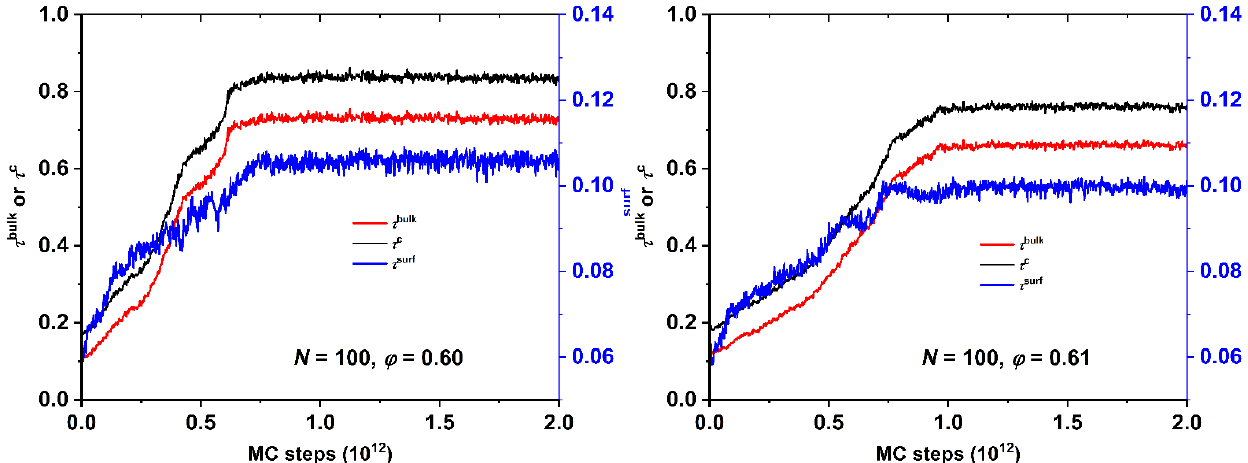
Figure 4. Double- y vs. x plots of bulk and total (left y-axis) and surface (right y-axis) versus the MC steps for the N = 100 system at packing densities of ( left panel ) ϕ = 0.60 and ( right panel ) 0.61.